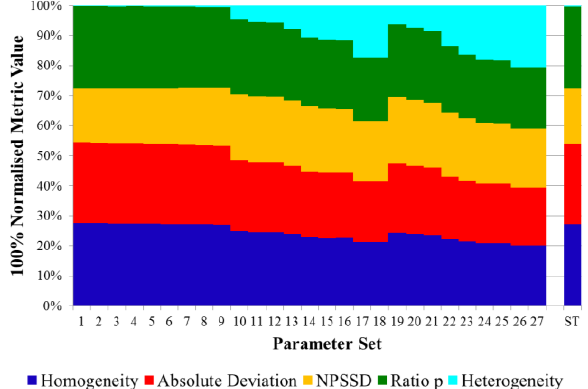
Figure 9 Comparison of two sets of metrics. A parameter set and a scene type match if the difference between the values of their corresponding metric values is small.